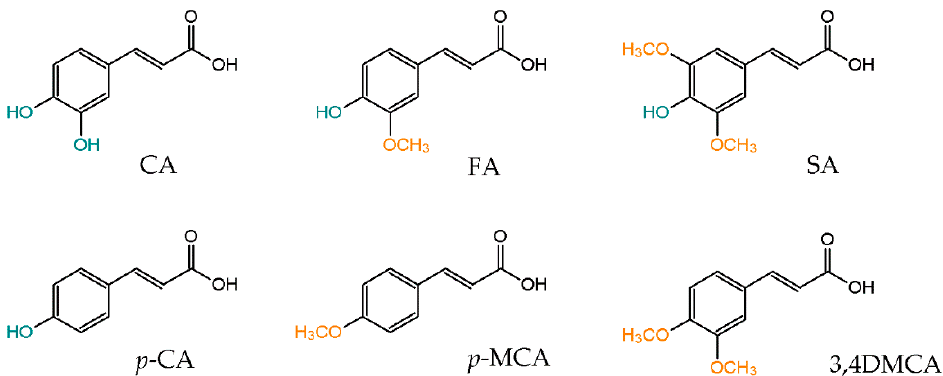
Figure 1. Chemical structure of dietary phenylpropenoic acids.